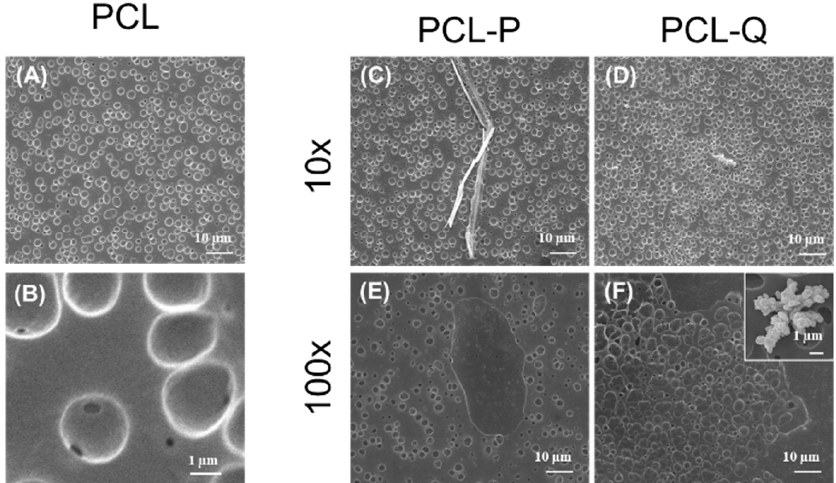
Figure 4. Physicochemical characterization of PCL coatings using chloroform in the coating formulation; SEM micrographs of the coatings with PCL alone ( A , B ) or with compounds P or Q: PCL-P10 ( C ), PCL-Q10 ( D ), PCL-P100 ( E ) and PCL-Q100 ( F ).